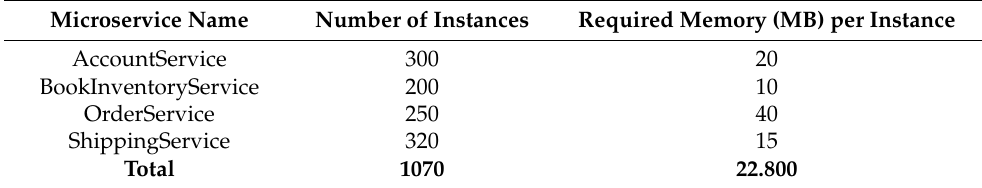
Table 1. Sample scenario for an online book shopping system using number of microservice in-stances and required memory per